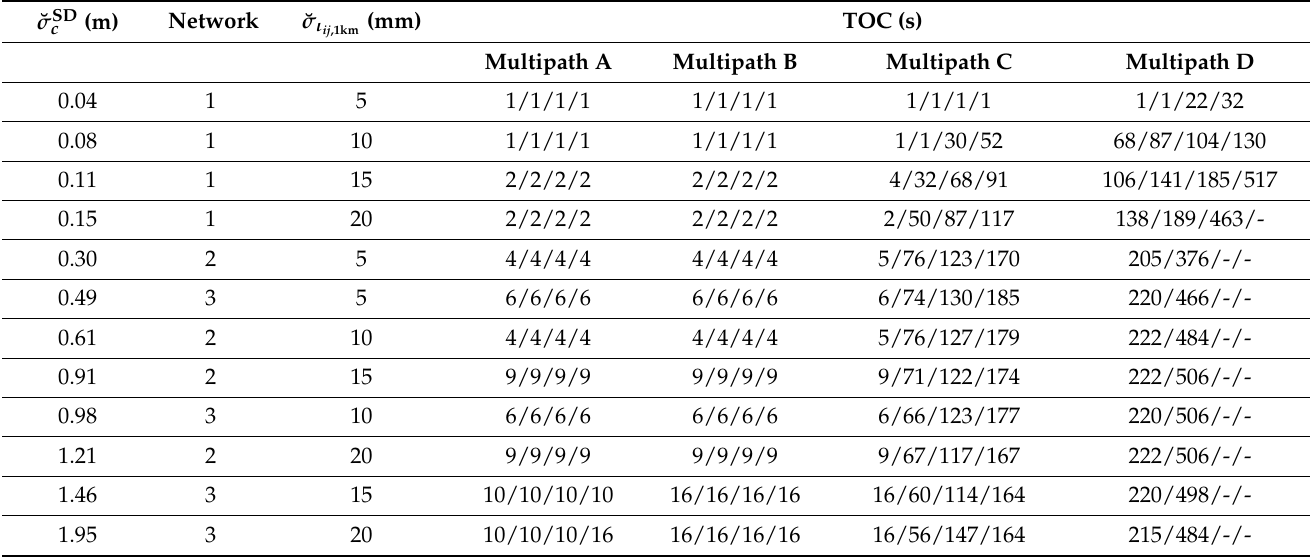
Table 9. Time to convergence (TOC) to 0.3 m for ambiguity-fixed HPLs for multipath scenarios A–D. Under each multipath scenario, the TOC for PMI H of 2 × 10 − 3 , 2 × 10 − 4 , 2 × 10 − 5 and 2 × 10 − 6 are separated by “/”. “-” represents the case when convergence is not reached until 30